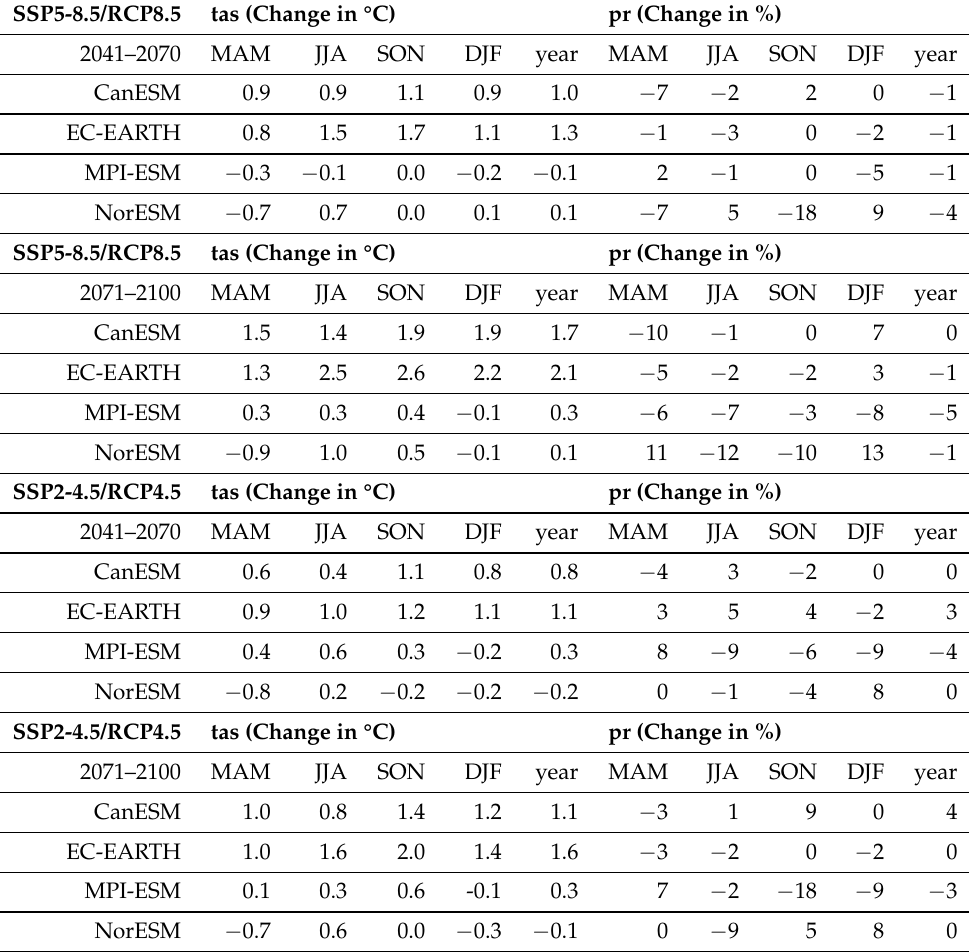
Table 4. Multi-realization-mean annual and seasonal difference in the GCM-specific climate change signal for temperature (tas) and precipitation (pr) between CMIP5 and CMIP6 (mean CMIP6 climate signal minus mean CMIP5 climate signal). Seasons are defined, as follows: spring (MAM), summer (JJA), autumn (SON), and winter